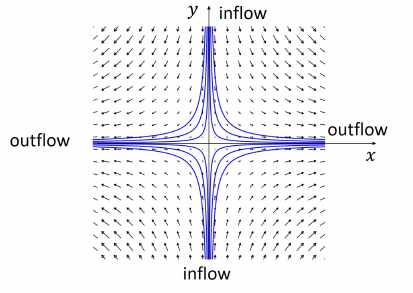
Figure 1. Sketch of the velocity field in a wall-free stagnation-point